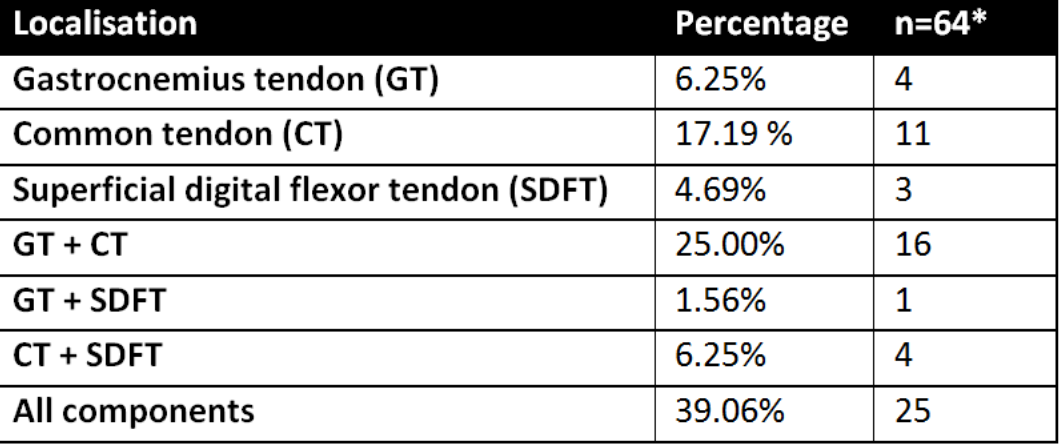
Table 1 : Achilles Tendon Injuries Localisation noted on Diagnostic Ultrasound *This table includes only major findings (clinically relevant) for each patient, but may include changes of bilateral Achilles tendons. A total of 64 Achilles tendons with abnormalities were evaluated. When different components were involved, the grade may have been different for each